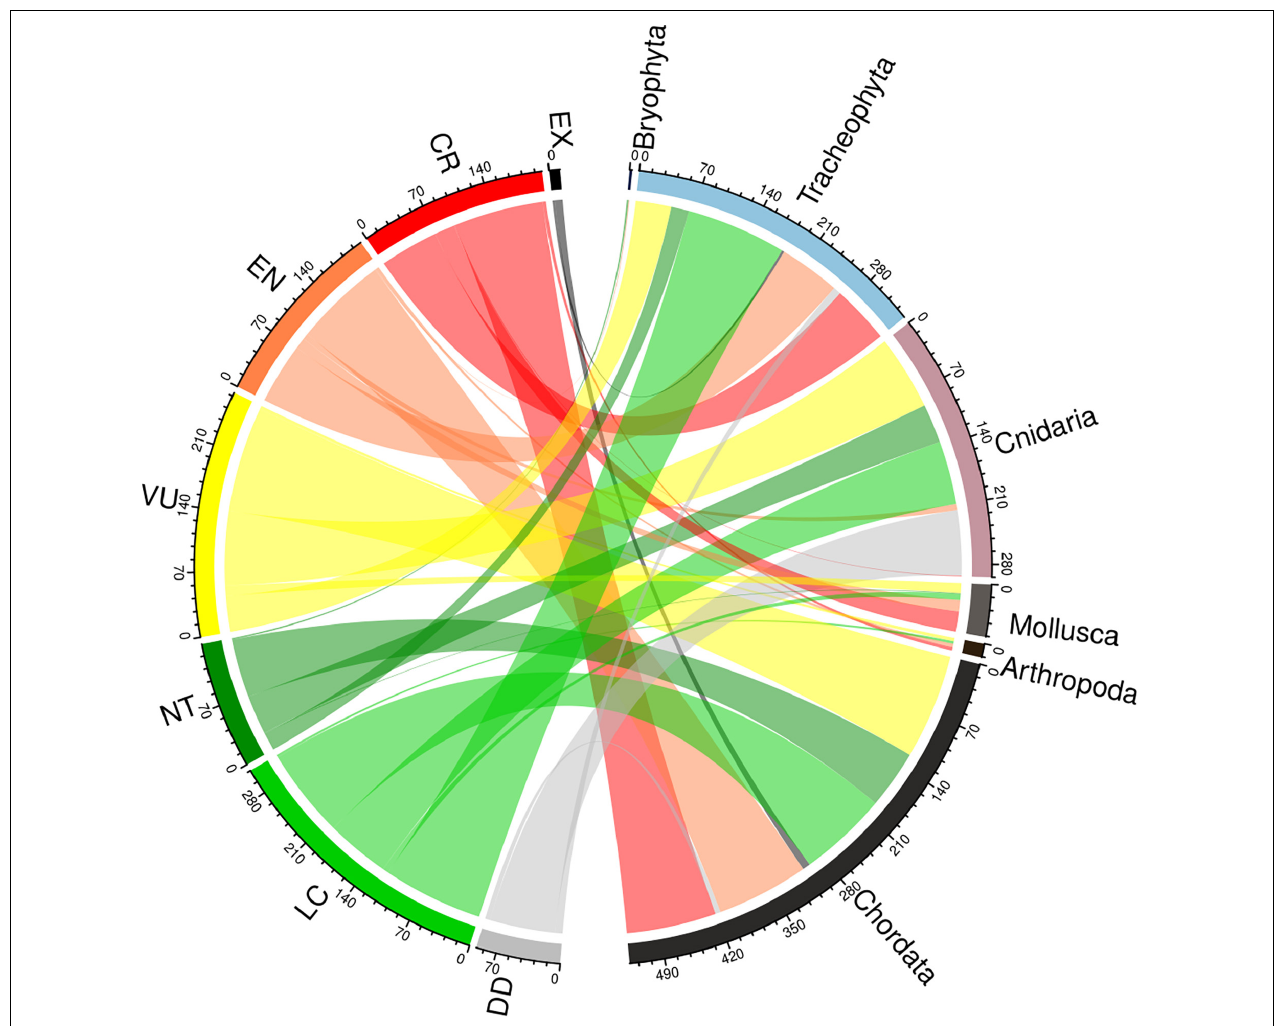
FIGURE 1 | Number of IUCN assessments per Categories where threat 8.2.2 is referred (left) related to the phyla (right) based on data from the IUCN Red List (IUCN, 2020c). EX category includes EW, NT include LR/nt and LC includes LR/lc and LR/cd. Five Fungi assessments also include this set but are not represented in this plot (chord diagram created using the circlize package in R by Gu et al.